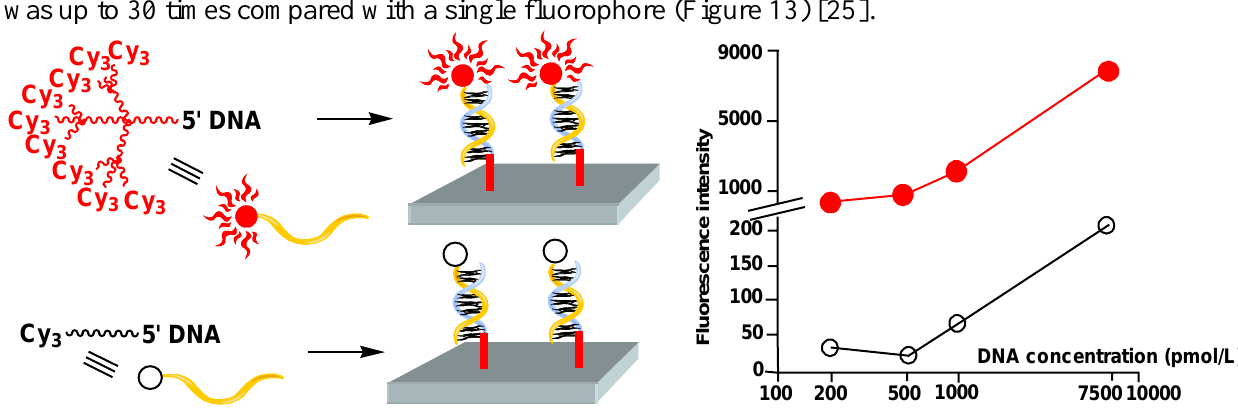
Figure 13. Schematic illustration of a dendron possessing nine Cy3 dyes and one PCR product (for instance HSV-1 amplicon). Fluorescence intensities of the microarray hybridization experiments plotted against the concentration of HSV-1 amplicons, depending on the number of attached fluorophores; white circles: 1 Cy3 per DNA double strand, red circles: 9 Cy3 per DNA double